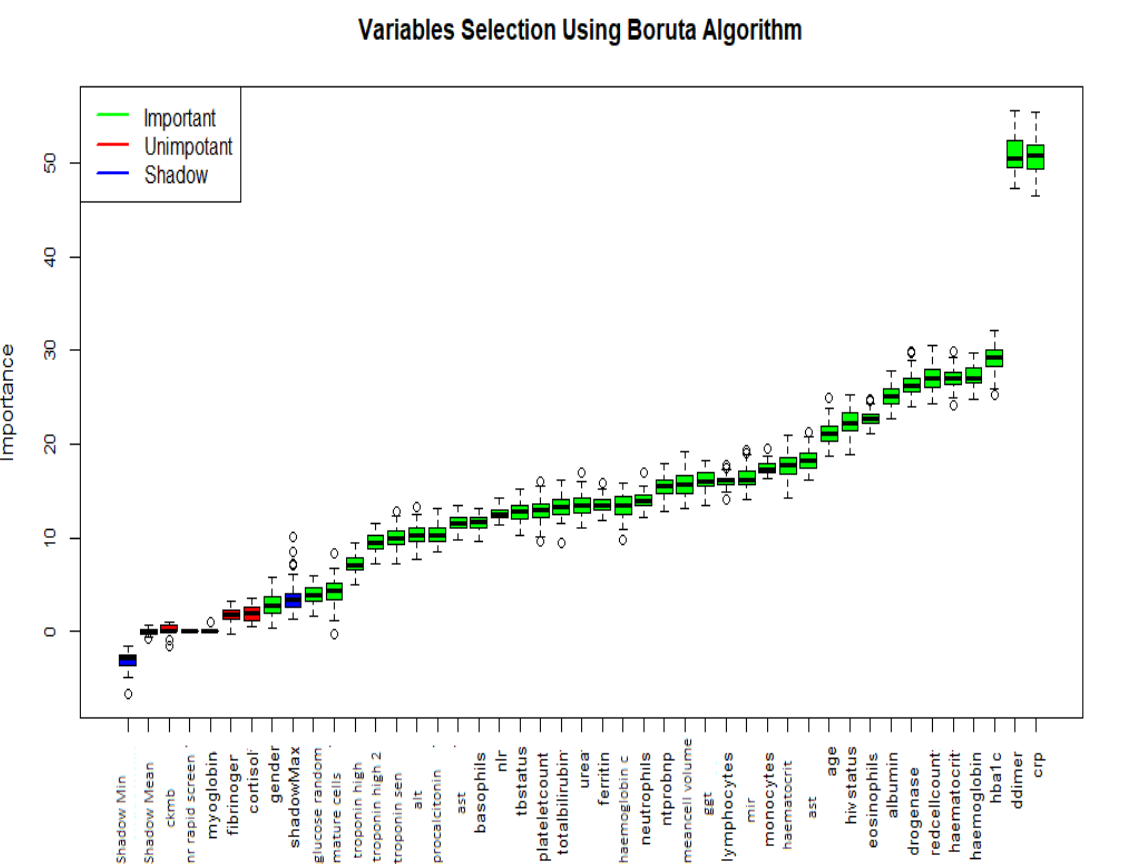
Figure 13. Variable selection using the Boruta Algorithm. Note that 5 variables were deemed less useful with the other 38 deemed